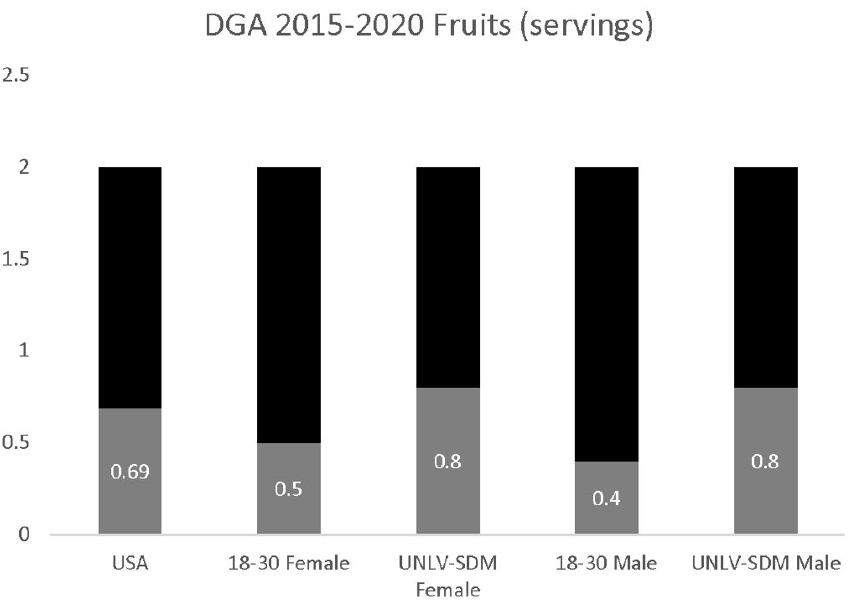
Figure 1. DGA fruit consumption analysis. Analysis of UNLV-SDM dental students’ fruit consump- tion among females and males, which was significantly higher than the U.S. population in general and young adults (18 to 30-year olds), more specifically, p = 0.031, but no significant differences were found between males and females, p = 0.899, and did not meet the DGA